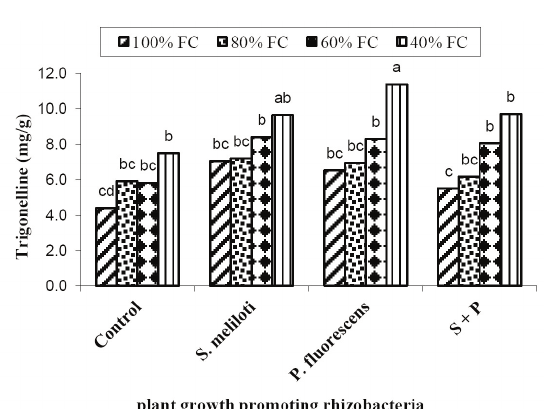
fig. 8 - Interaction of PGPR and soil water content on the WUe of fenugreek.